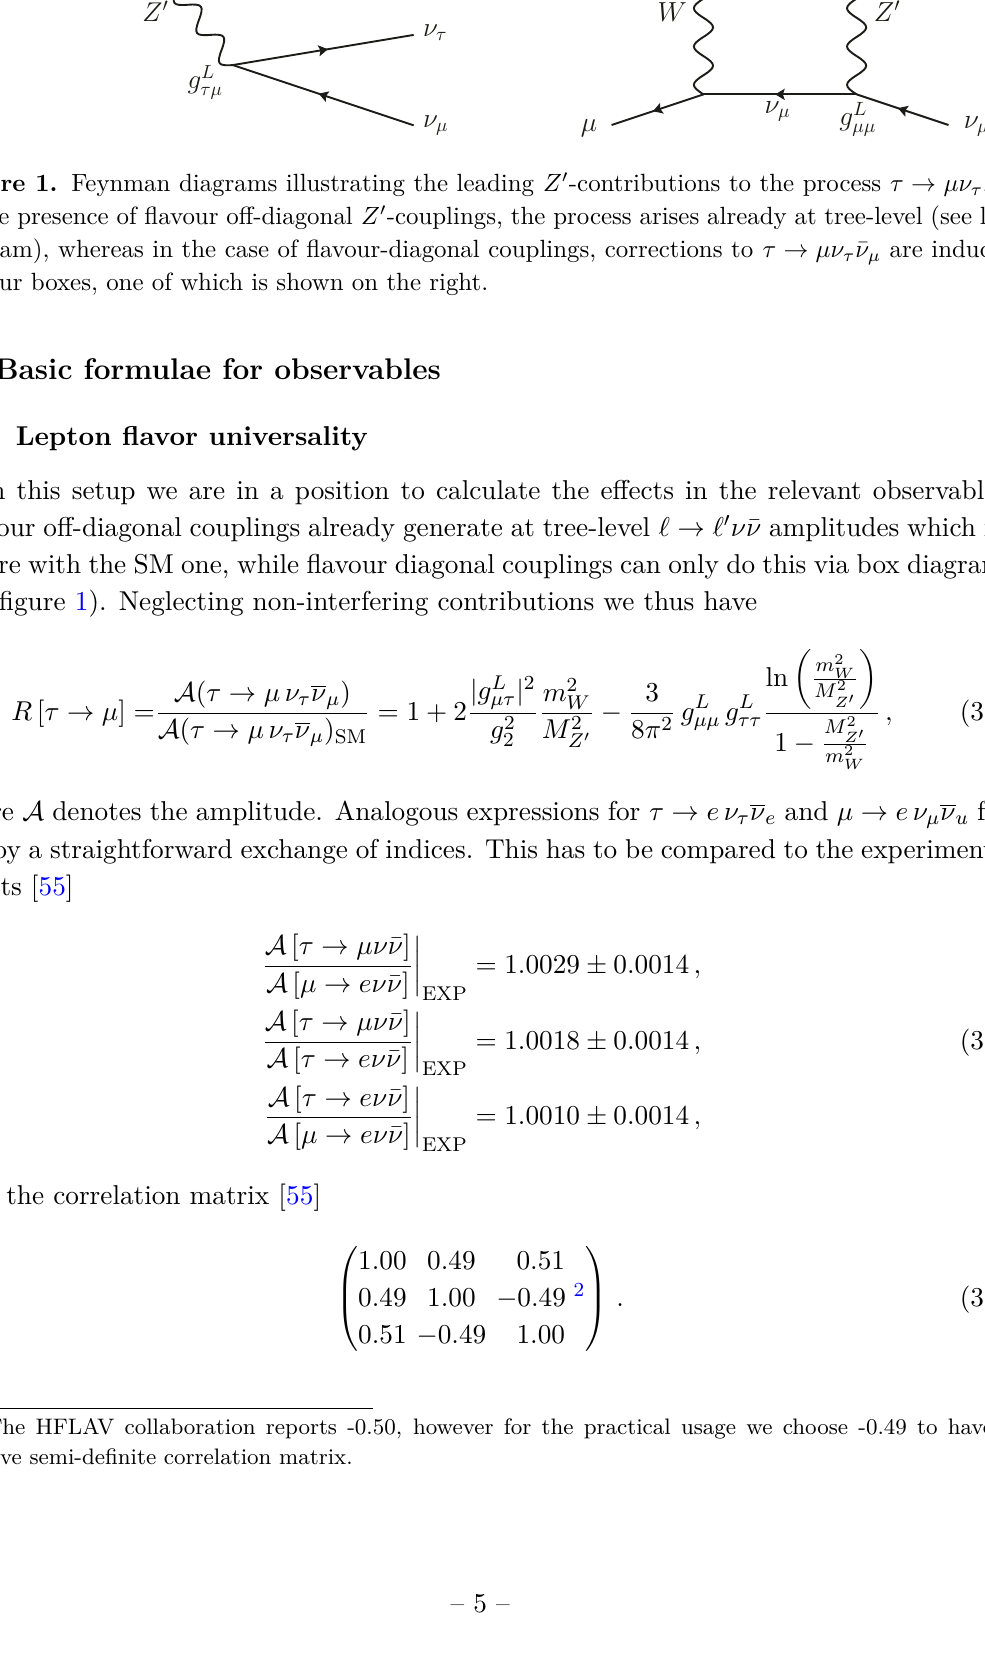
¯ ν are induced τ µ